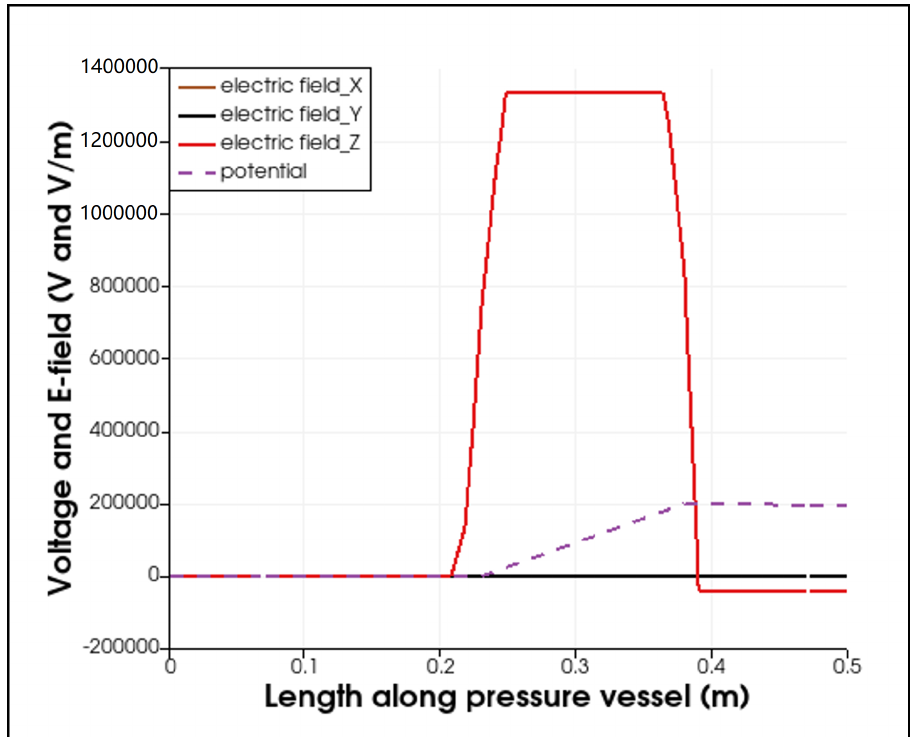
Figure A6. Voltage and fields across the insulation